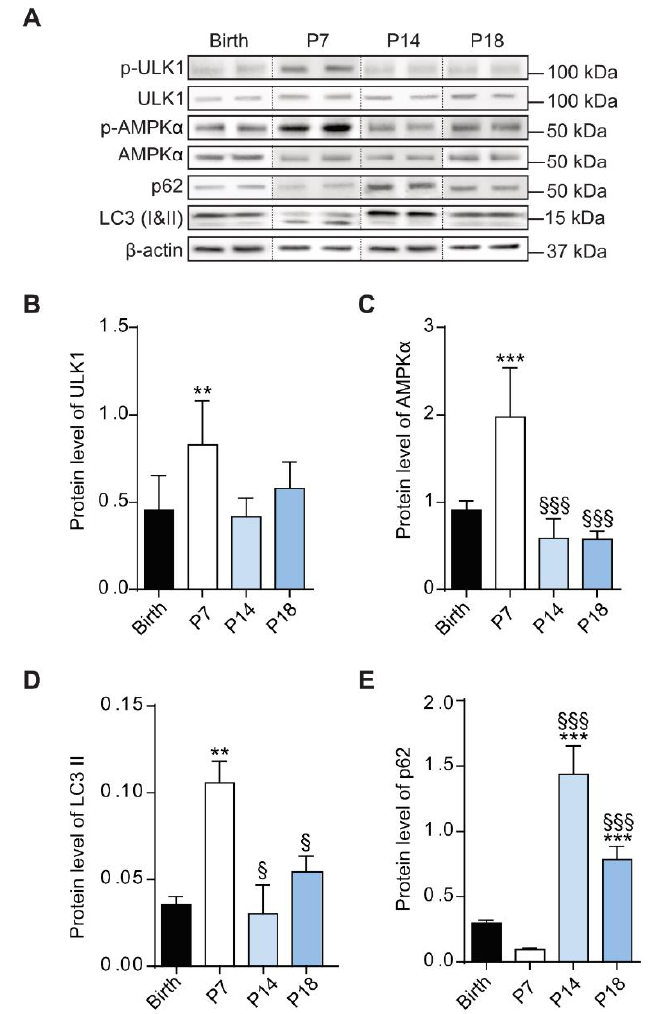
Figure 4. Protein levels of autophagic markers during rat retinal development. ( A ) Western blots depict representative immunoreactive bands of proteins involved in autophagic mechanisms in rat retinas, from birth to P18. Quantitative analysis of optical density of the ratio of immunoreactive bands between pSer 555 -Ulk1 / Ulk1 ( B ), p -AMPK α / AMPK α ( C ); LC3 II / β -actin ( D ) and p62 / β -actin ( E ). One-way ANOVA followed by Bonferroni’s multiple comparisons test was used as statistical analysis of mean ± SEM datasets ( n = 6; ** p < 0.01, *** p < 0.001 vs. birth, § p < 0.05, §§§ p < 0.001 vs. P7).